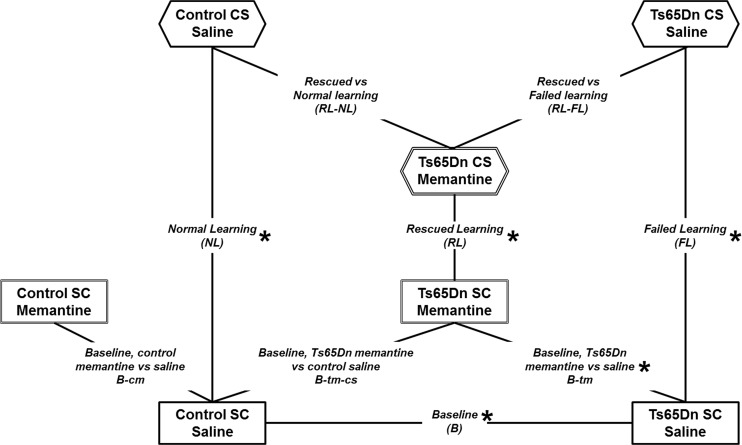
Relationships among pairwise group comparisons.Eight groups of mice, control and Ts65Dn, not trained in CFC (SC, shock context) and trained in CFC (CS, context shock), injected with either saline or memantine, were generated. The four SC groups represent baseline (B) conditions and are shown in rectangles in the lower part of the figure. Three CS groups are shown in hexagons. Lines connecting groups indicate the nine pairwise comparisons of biological interest that are discussed here. Each comparison is labelled with the complete name and the abbreviated name used in the text. Summary data for all comparisons, except B-cm, are presented in Table 2 (for B-cm data, see reference 39). *, comparisons analyzed for data shown in Figs. 2–7. See Table 1 for additional information.